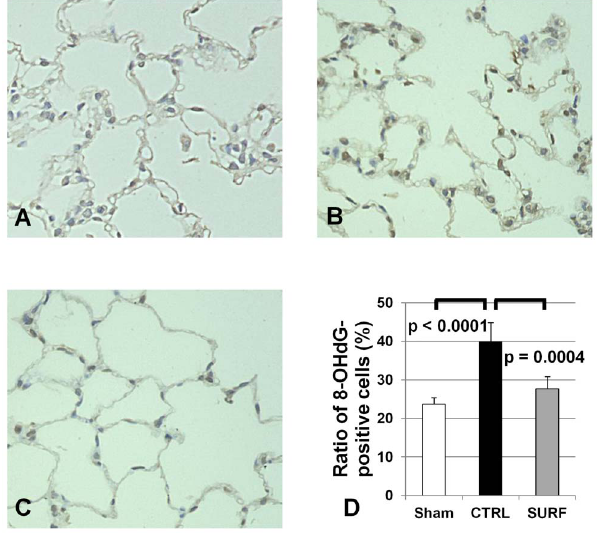
Figure 5. Immunohistochemical staining and the assessment for oxidative damage (original magnification 400 6 ). (A) Sham group. (B) CTRL group. (C) SURF group. In the 8-OHdG staining, the ratio of 8-OHdG-positive cells was significantly lower in the Sham and SURF groups than that in the CTRL group (D). All values are expressed as the mean 6 SD.